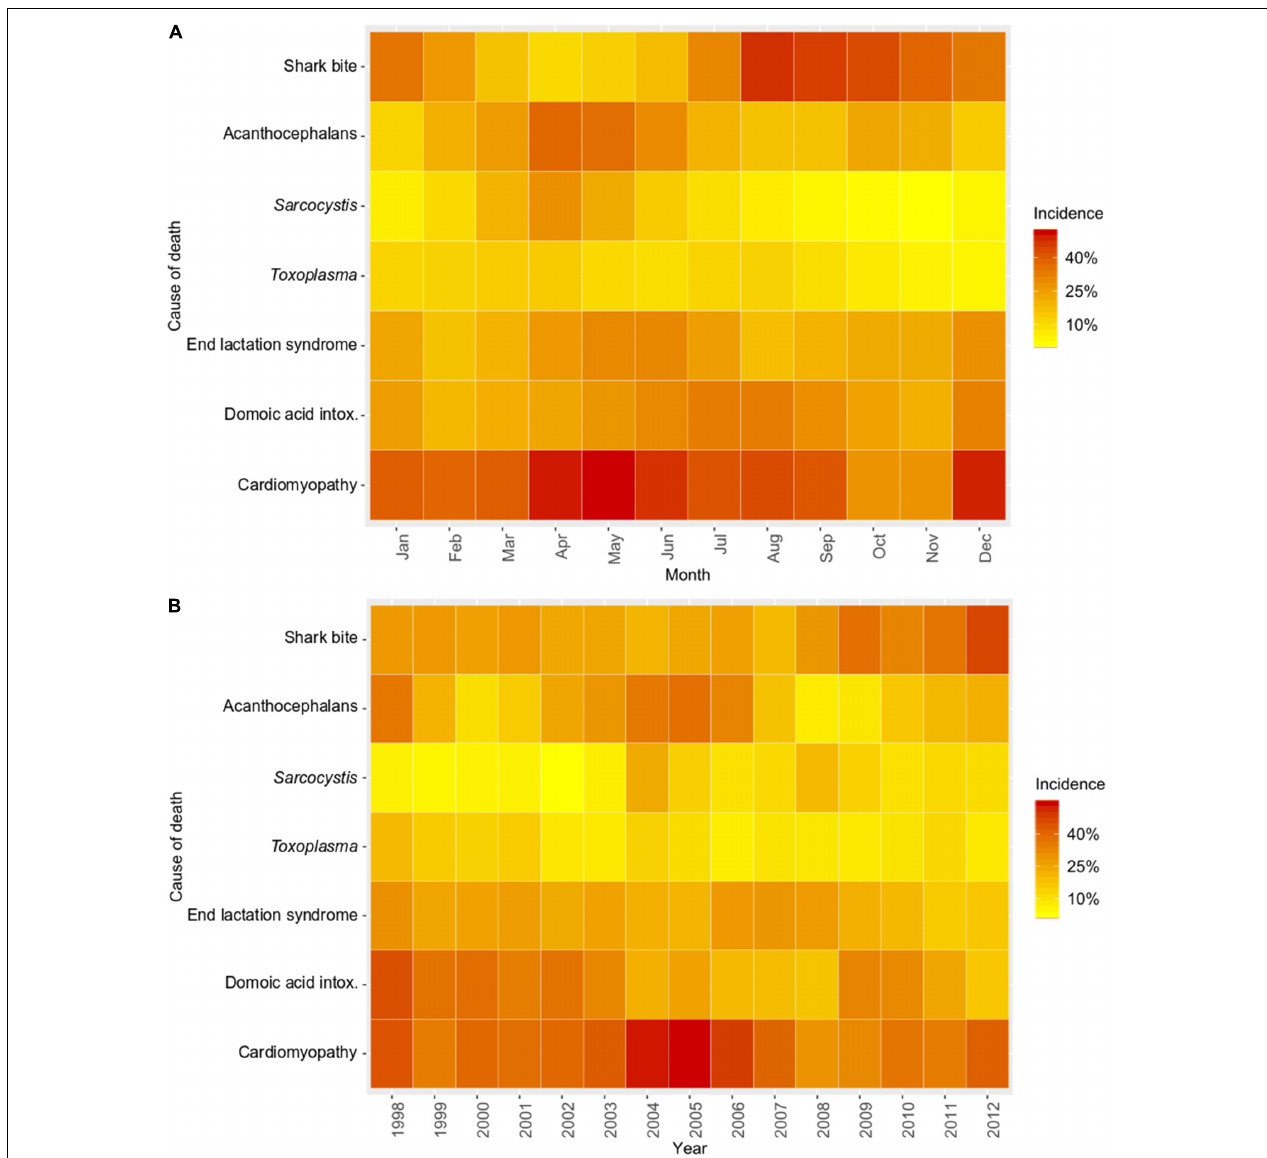
FIGURE 4 | Temporal trends for common causes of southern sea otter ( Enhydra lutris nereis ) death for 560 animals necropsied 1998 – 2012. Temporal trends are depicted as heat maps of the mean proportional incidence of each cause of death (pooled top 4 COD). Cases were grouped by month (A) : illustrating seasonal variation, and by year (B) : illustrating inter-annual variation. Warmer colors (dark orange and red) illustrate higher proportional incidence, while cooler colors (light orange and yellow) illustrate lower incidence. Domoic acid intox. = Domoic acid intoxication.